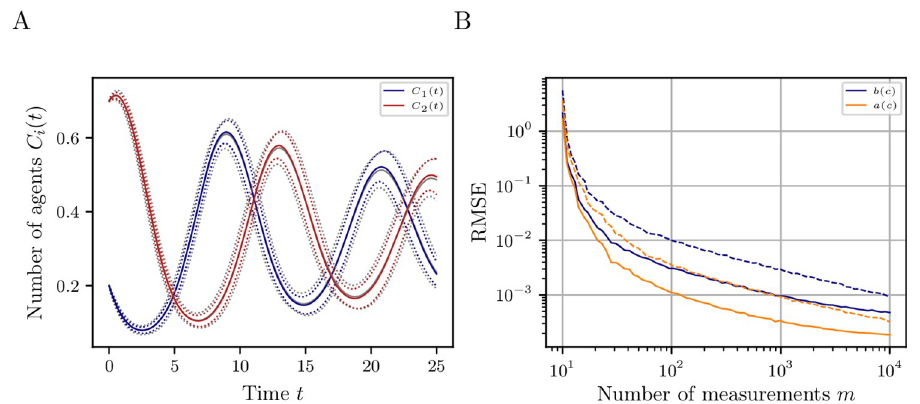
Fig 5. Prediction of extended voter model for complete networks. (A) Expectation (solid) and standard deviation (dashed) of the SDE limit model C i ( t ) and its data-driven approximation (gray) estimated from 10 3 Monte Carlo simulations for the dynamics of the EVM of Section 3.2 for N = 5000 agents and initial state c ð 0 Þ ¼ ½ 0 : 2 ; 0 : 7 ; 0 : 1 � > 2 X . The relative number of agents of type S 3 can be reconstructed using (10) and is therefore not displayed. The approximate moments (gray solid and dashed lines) agree with the SDE limit model. (B) Approximation and evaluation error of the drift and diffusion estimates for the EVM in Section 3.2 compared to the exact SDE limit model (5) depending on the number of measurements m for fixed k 1 = 10 (dashed), k 2 = 100 (solid) and N = 5000 agents. The error is averaged over 100 simulations. Clearly, for higher amounts of training data a smaller error can be expected. This holds for both parameters m and k .